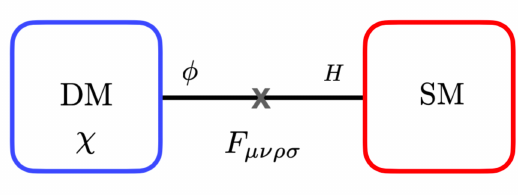
Figure 1 . Schematic diagram for flux-mediated dark